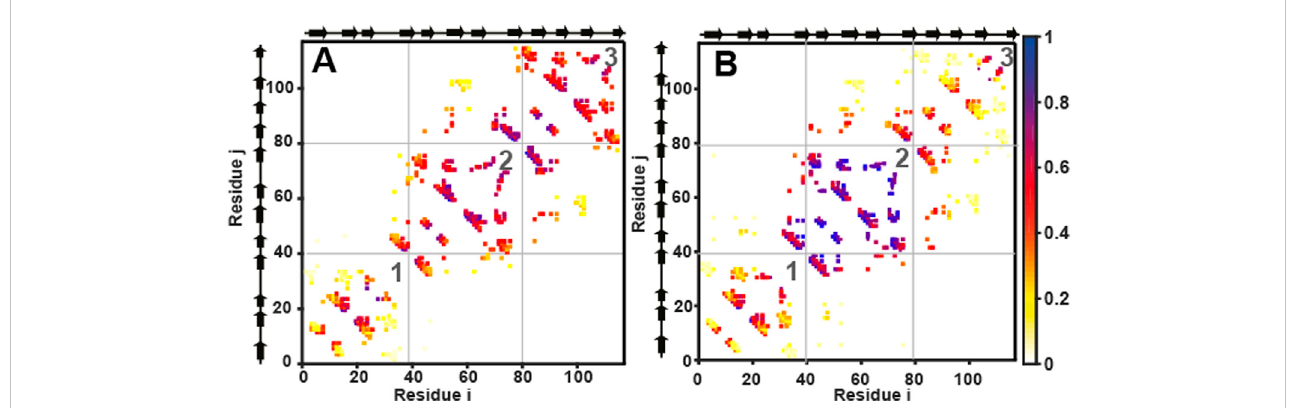
FIGURE 5 C α structure-based simulations reveal distinct folding pathwaysfor wtHis and csHisH90G. Average contact maps for (A) wtHis and (B) csHisH90G atQ = 0.4. Average contact maps are a two-dimensional representation of the average partially folded structure of the protein when the protein is 40% folded. Residuesareindexed onthexandthe y -axes.Secondary structuralelements oftheresidues aremarkedbesidetheaxesonthetopandtheleft.Acoloredbox placed at ( i, j ) and ( j, i ) means that a contact is present between residues i and j . Contacts are colored based on how formed they are, with one indicating fullyformedand0indicatingunformed.Thecolorbarisgivenontheright.TheN-terminal,central,andC-terminaltrefoilsarelabeled1,2,and3,respectively. Average contact maps for wtHis and csHisH90G show that wtHis initiates folding from its C-terminal trefoil, while folding occurs from the central trefoil in csHisH90G. The average contact map for 3Foil at Q = 0.4 is given in Supplementary Figure